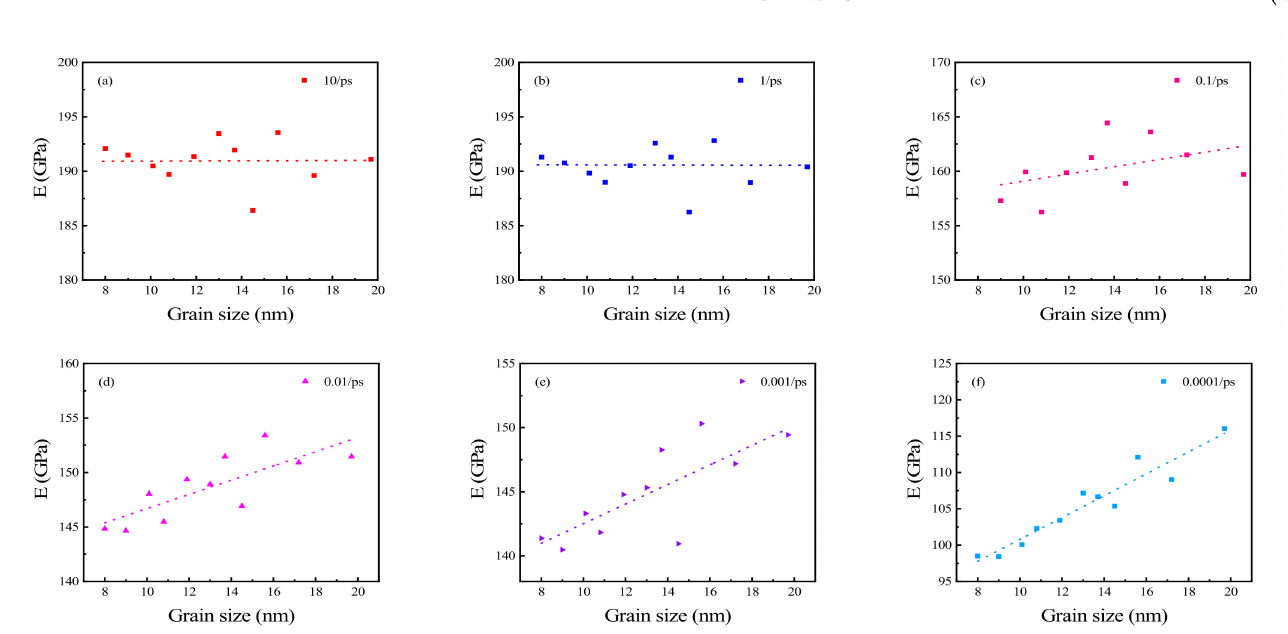
Figure 5. Young’s modulus of polycrystalline Cu 6 Sn 5 at strain rates of ( a ) 10 ps − 1 , ( b ) 1 ps − 1 , ( c ) 0.1 ps − 1 , ( d ) 0.01 ps − 1 , ( e ) 0.001 ps − 1 , and ( f ) 0.0001 ps − 1